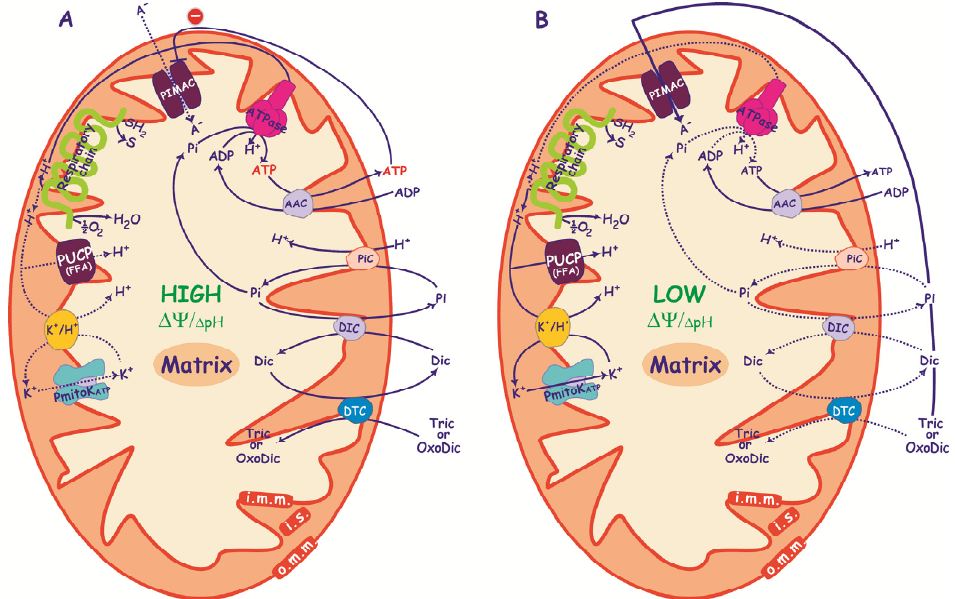
Figure 4. DWM uptake of Pi, dicarboxylates (Dic), oxodicarboxylates (OxoDic) and tricarboxylates (Tric) under conditions of high ( A ) and low ( B ) ∆Ψ / ∆ pH and